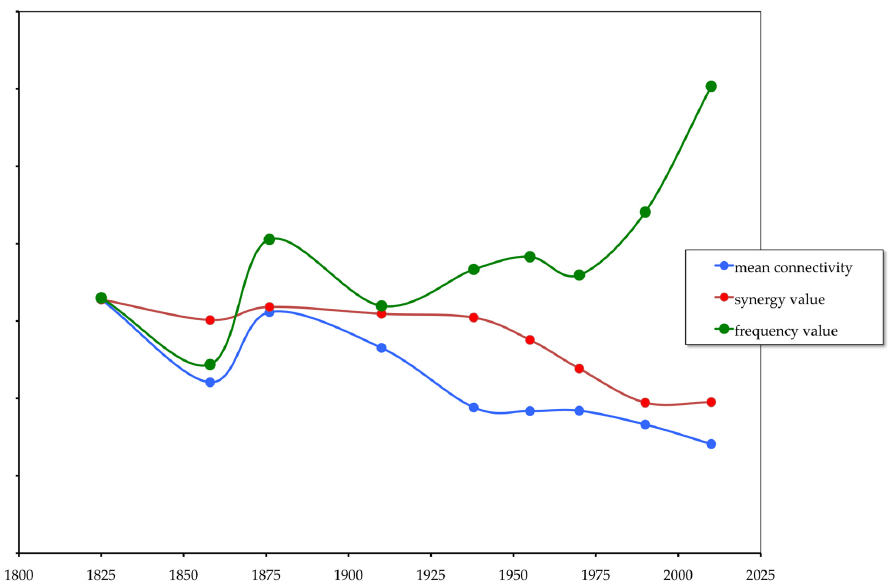
Figure 8. The trend of resilience parameters in the grid of Florence in the period 1825–2015. Normalized values at 1825.